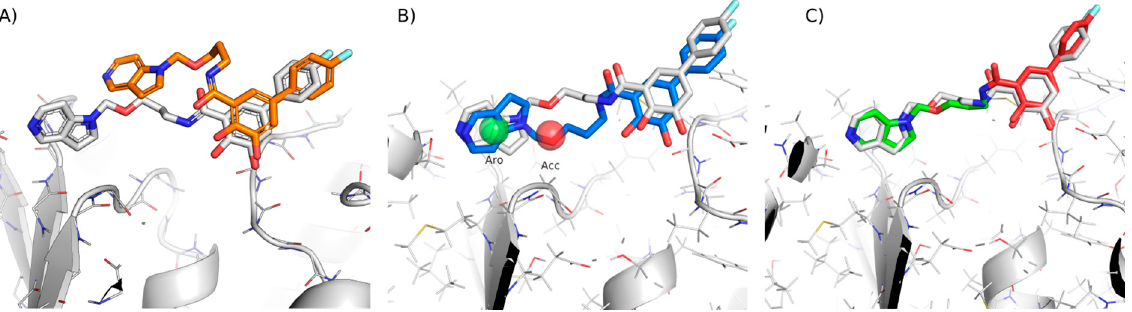
Table 1. RMSD results obtained using different docking methods.